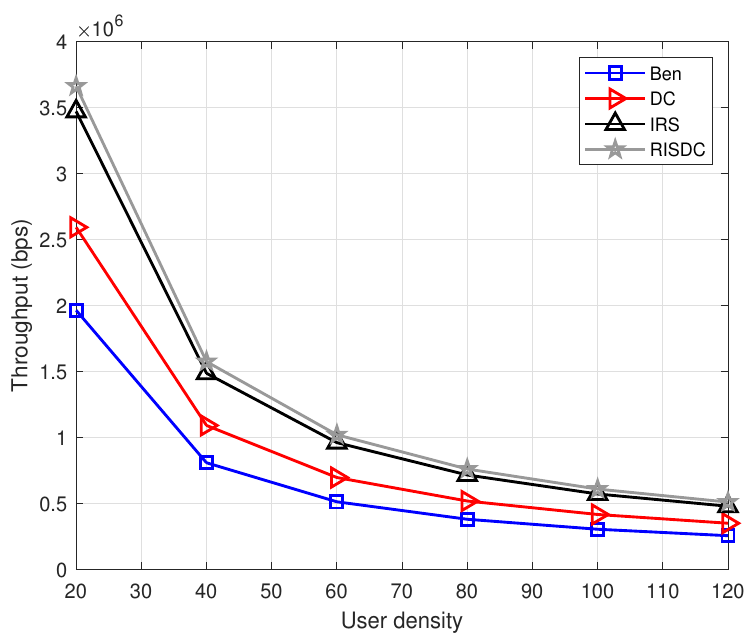
Figure 7. Variation of throughput with respect to number of users when ρ bs = 4, ρ ris = 6, α = 1, and µ b =